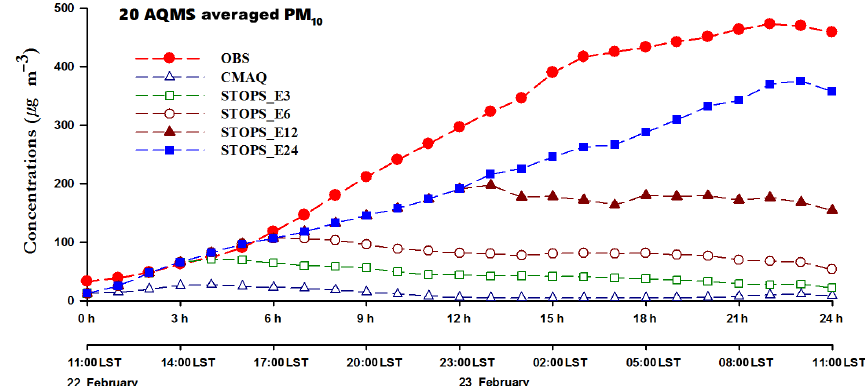
Figure 9. Comparison of observed, CMAQ-simulated, and STOPS-simulated PM 10 concentrations during the 24h from 10:00LST on 22 February